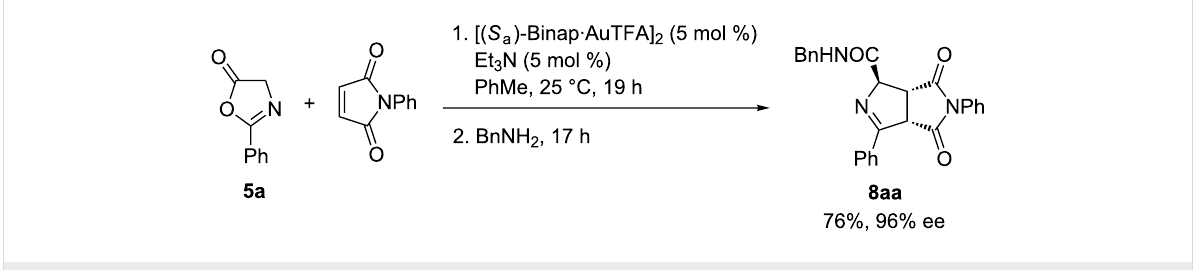
Scheme 3: Formation of the amide 8aa .